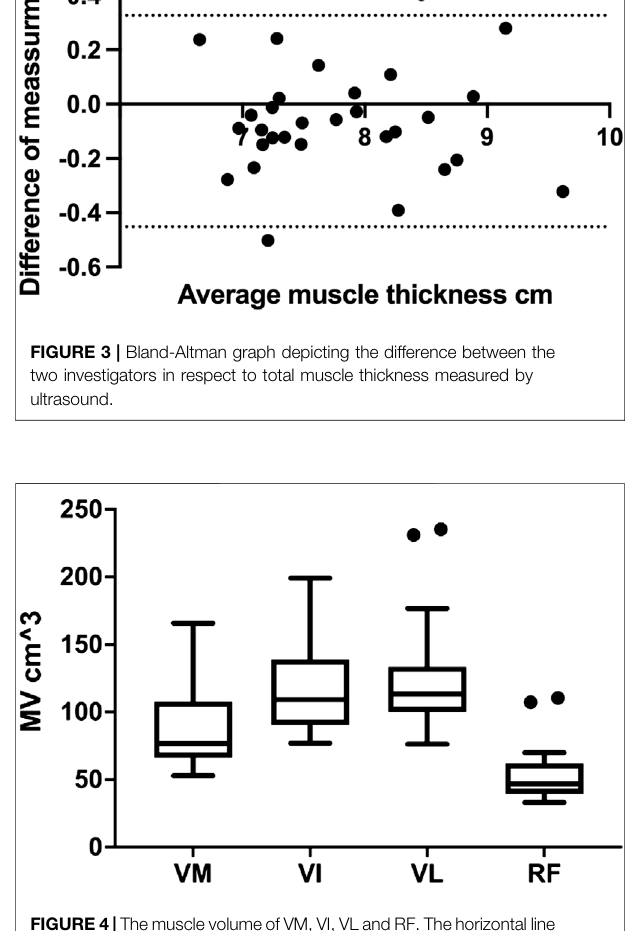
FIGURE 4| The muscle volume of VM, VI, VL and RF. The horizontal line shows the median, while the box encompasses the 50th percentile and the whiskers encompass the minimum and maximum values, outliers are displayed as points. Outliers are de fi ned according to Tukey, as values exceeding more than the 75 percentile plus 1.5 IQR. RF = m. rectus femoris, VL = m. vastus lateralis, VI = m. vastus intermedius and VM = m. vastus medialis.